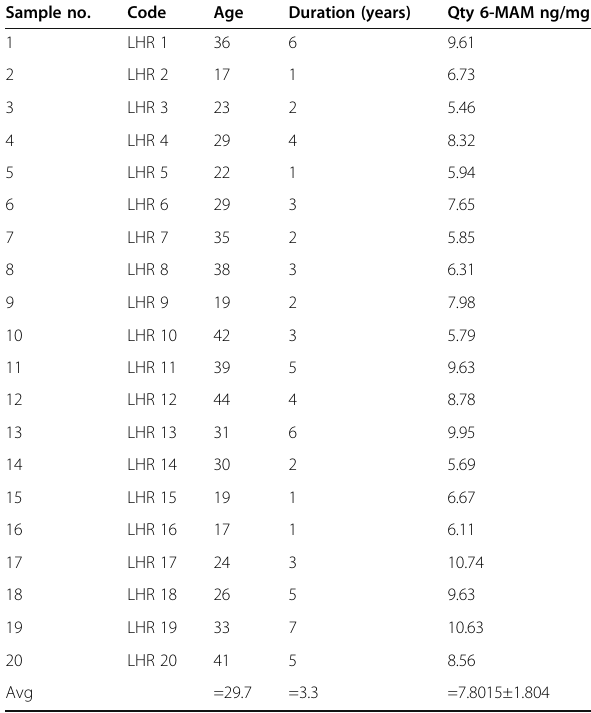
Table 5 Demographics of the regular addicts and subjects from de-addiction center groups